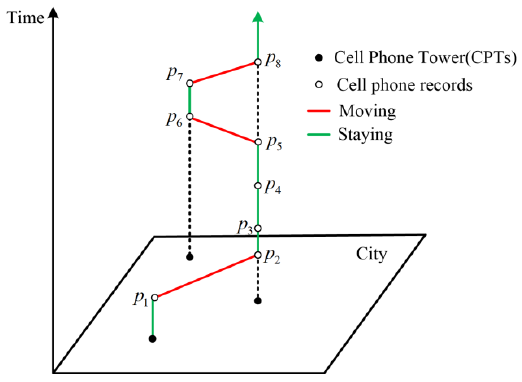
Figure 3. Space-time trajectory of an individual cell phone record.